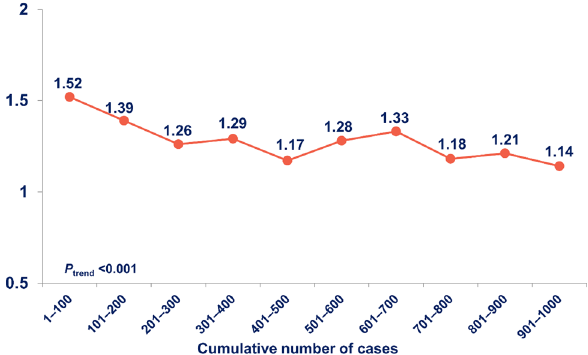
Figure 2. Temporal trend in puncture attempts of the distal radial access showing significantly decreasing from 1.52 in 1–100 patients to 1.14 in 901–1000 patients.